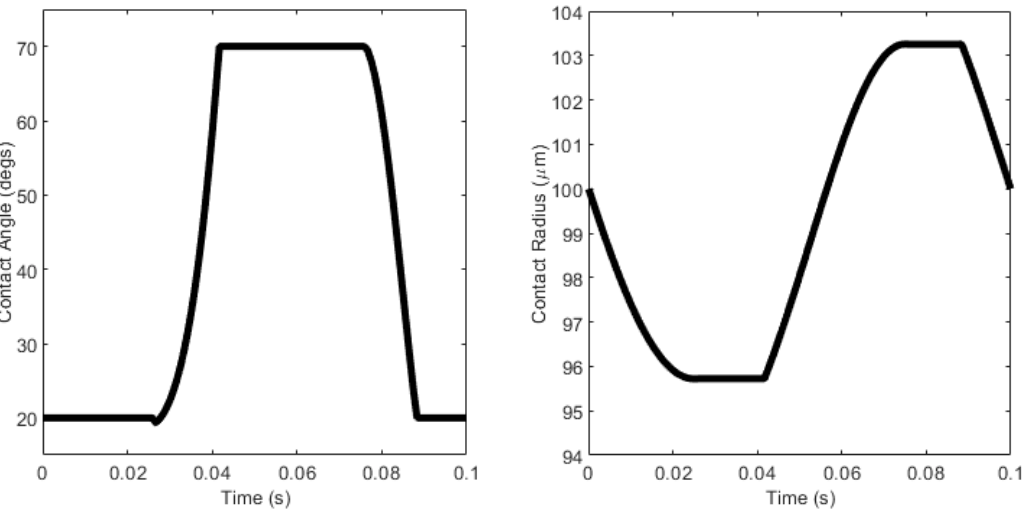
Figure 12. Variation of contact angle (left) and contact line radius (right) as a function of time for the scenario demonstrated in Figure 10 (left). In this case, a frequency of 10 Hz is arbitrarily assumed.